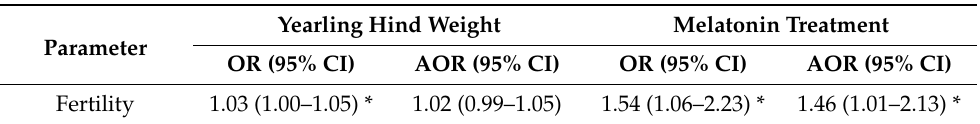
Table 2. Adjusted (AOR) and unadjusted (OR) odds ratios of fertility from Iberian yearling hind weight and treatment with melatonin